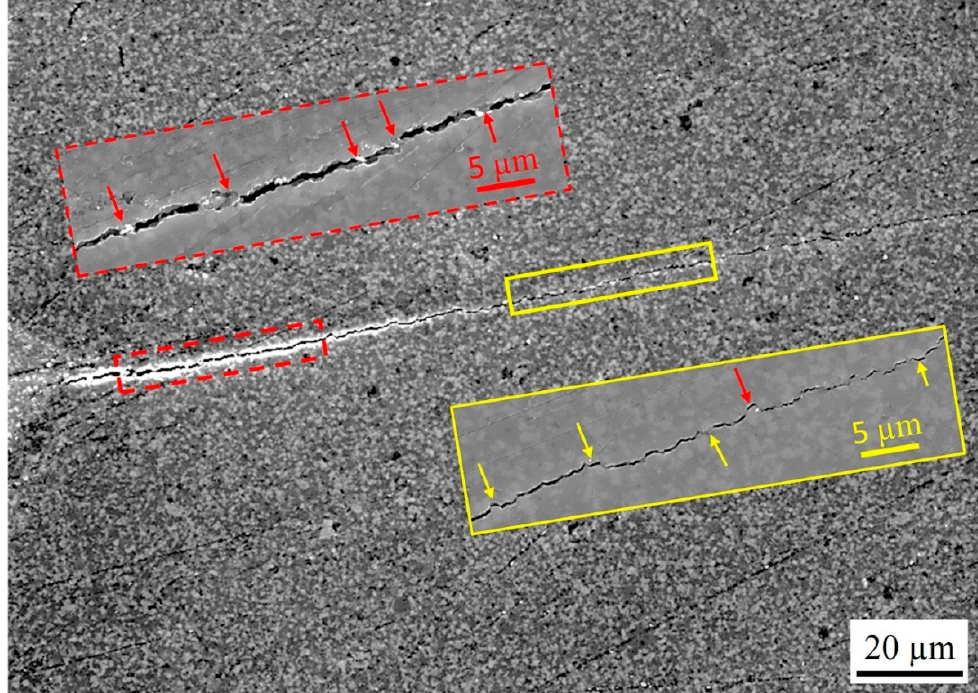
Figure 4. Vickers indentation crack induced on the surface of the Al 2 O 3 ‐ 40 vol.% TiC composite.